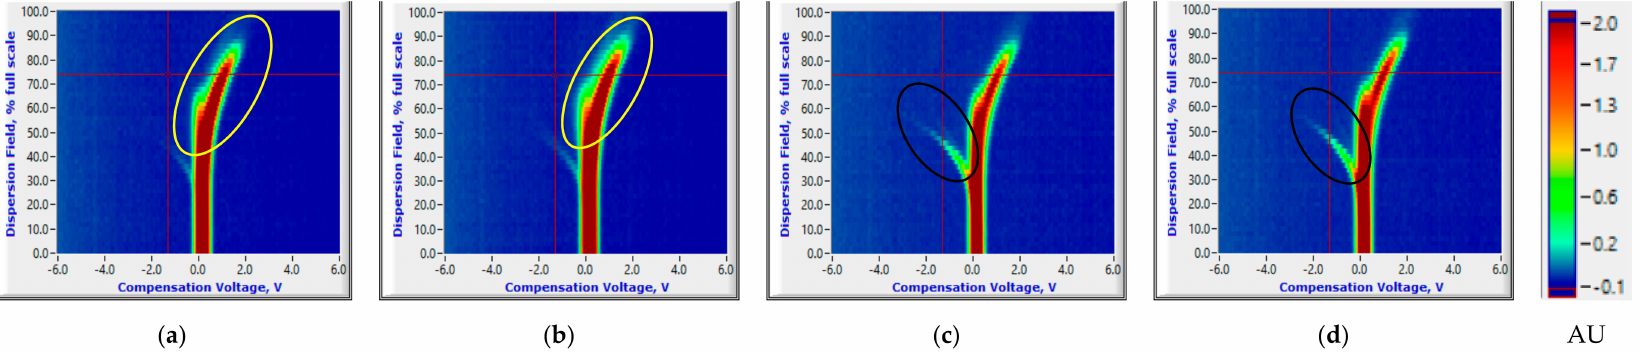
Figure 7. Ion current (AU) plots (corresponds to the color scale) at 0th (healthy control ( a ) and P. ultimum inoculated ( b )) and 15th (healthy control ( c ) and P. ultimum inoculated ( d )) days after inoculation for the Russet Burbank tuber sample replicates stored at reduced temperature (4 ◦